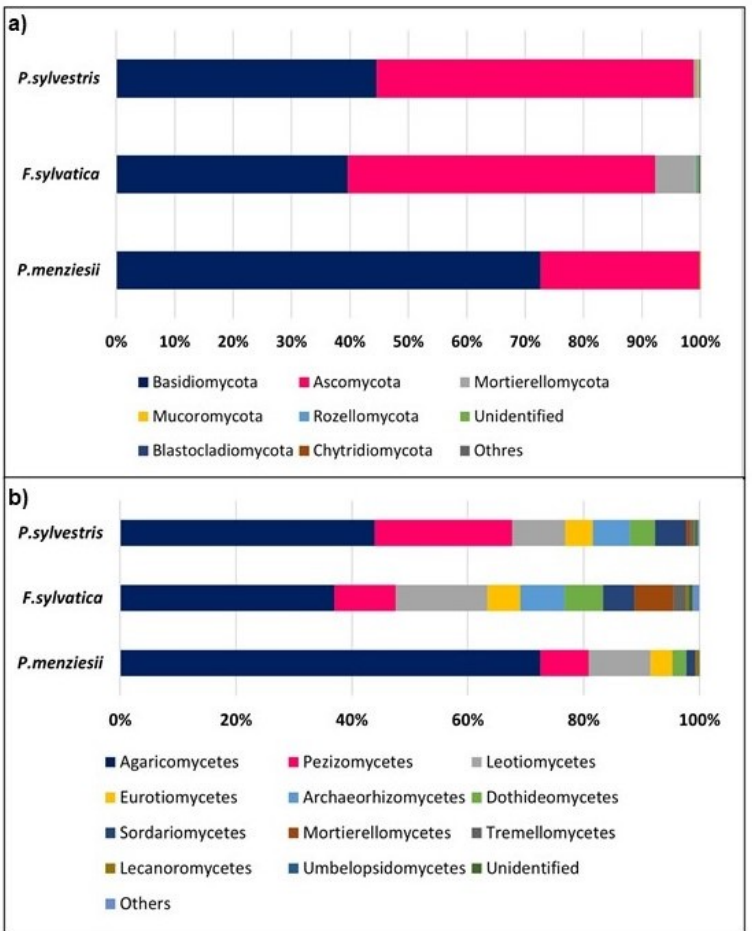
Figure 2. Taxonomic composition of fungal communities associated with Pseudotsuga menziesii , Fagus sylvatica , and Pinus sylvestris roots at the phylum ( a ) and class ( b ) levels on experimental plots. A total of 371 genera were observed, of which 19 were detected in all the samples. The most abundant observed genera were Tomentella (relative abundance of 11.02%, for P . menziesii , even 17.54%), Russula (10.73%), Thelephoraceae unidentified genus (9.00%), and Hydnotrya (7.30%) (Figure 3). These genera were detected in the roots of all the analyzed tree species. Archaeorhizomyces and Serendipita were not detected in the Douglas fir roots, whereas Pseudotomentella , Piloderma , and Tuber were not detected in the Scots pine root samples.